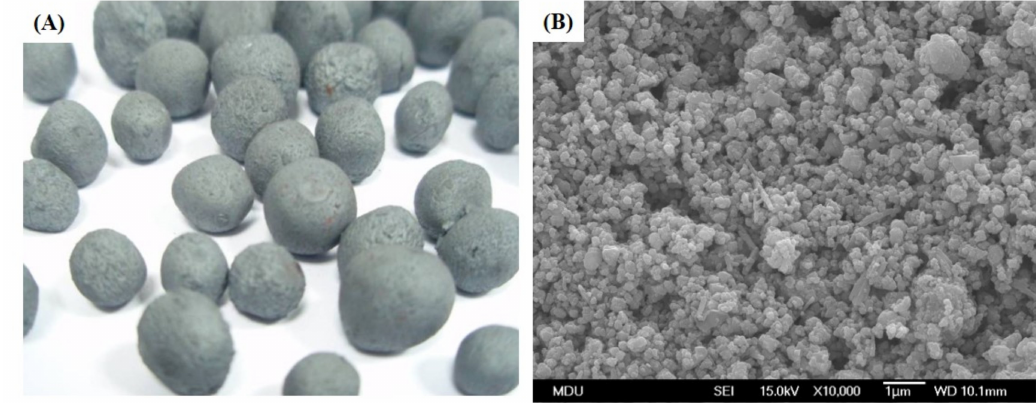
Figure 2. ( A ) exterior image of the Fe 3 O 4 catalyst; ( B ) SEM microphotograph (10,000 × ) of the Fe 3 O 4 catalyst taken in secondary electron imaging (SEI) mode with a working distance (WD) of 10.1